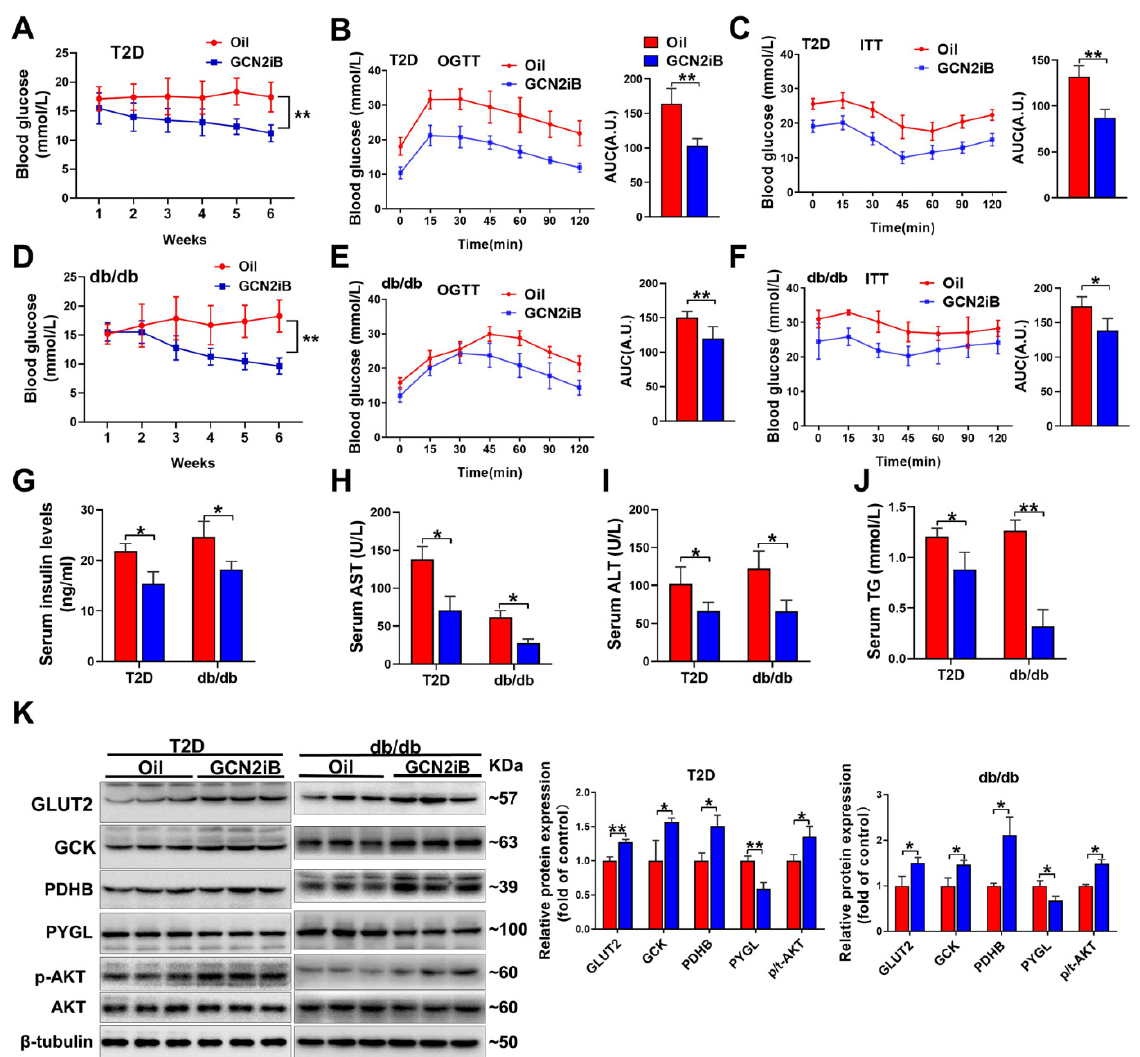
Figure 3. GCN2iB ameliorates hyperglycemia, liver dysfunction, and insulin resistance in T2D